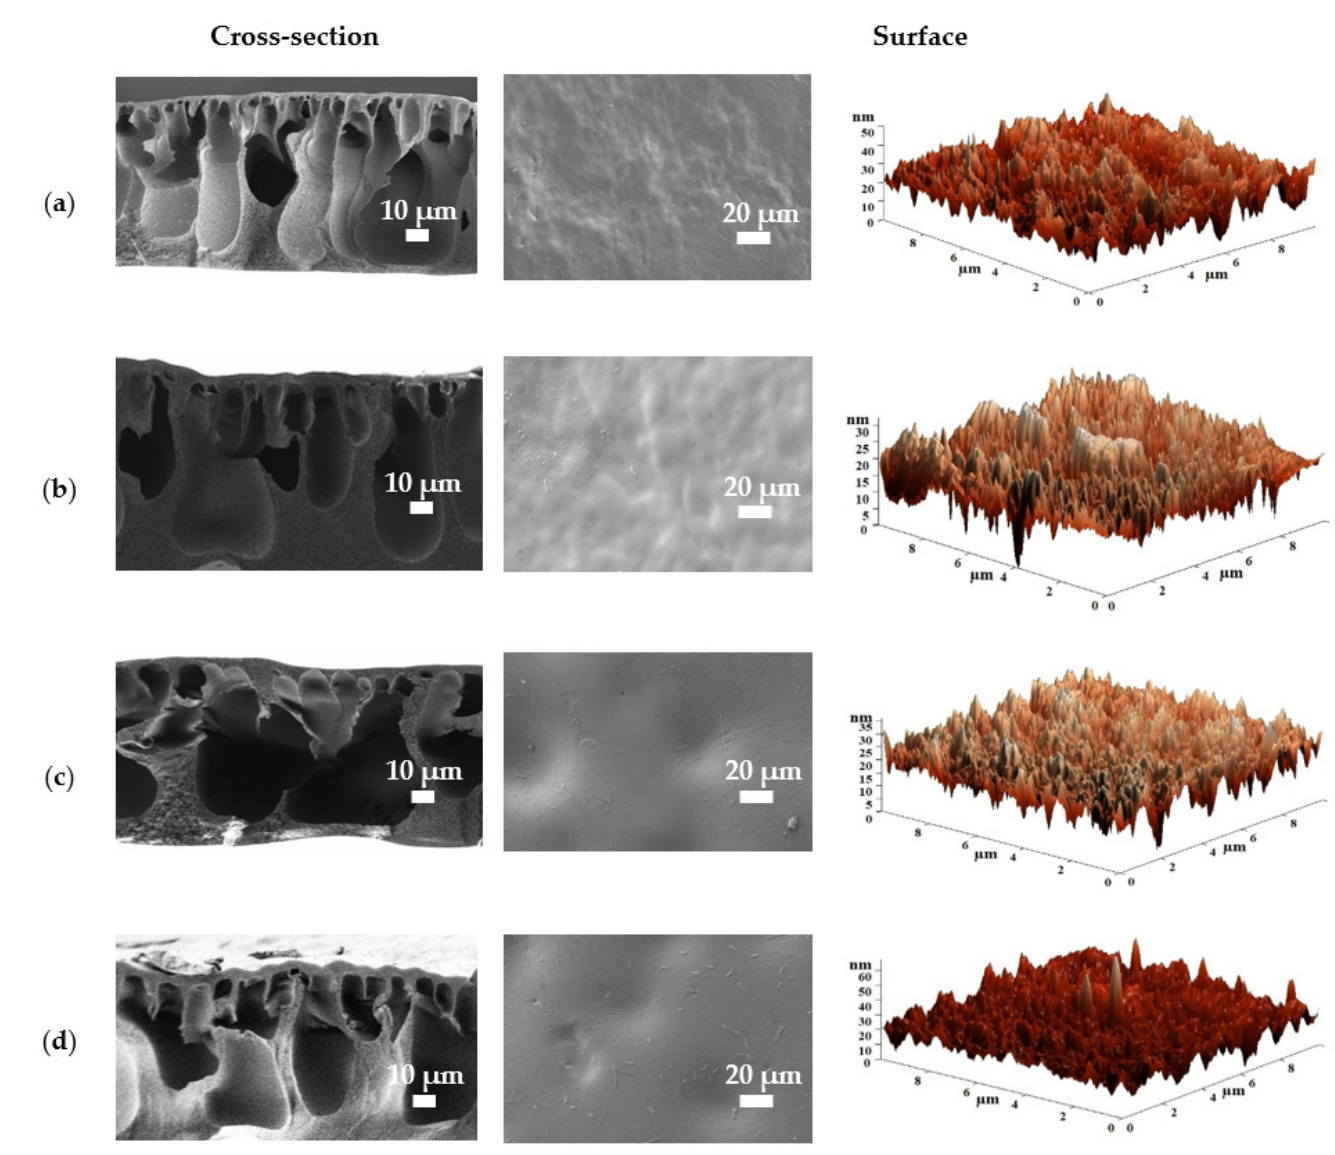
Figure 6. Cross-sectional and surface SEM micrographs and surface AFM images of ( a ) CA-12, ( b ) CA-12/Zn(SEB) (1%), ( c ) CA-12/Zn(BDC)Si (1%), and ( d ) CA-12/Zn(BIM) (1%) membranes.